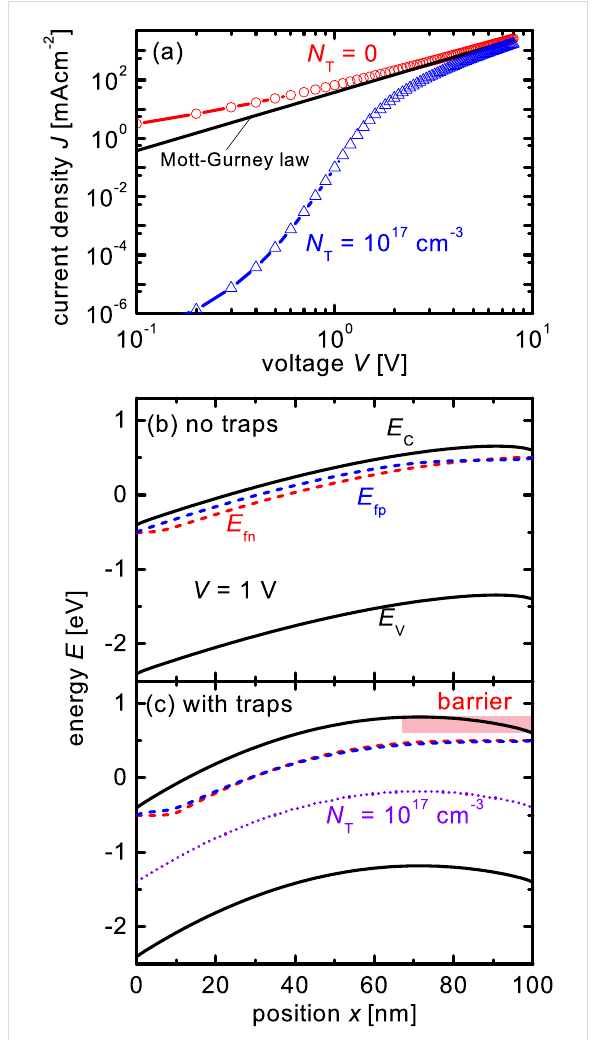
Figure 1: (a) Current–voltage curves of a device with and without charged acceptor-like defects with a total concentration N T = 10 17 cm − 3 and a Gaussian width of σ = 100 meV are compared to the Mott–Gurney law (Equation 1). Band diagram of the device (b) without charged defects and (c) with charged defects. The acceptor-like defects in (c) create a barrier (indicated with a light red background) due to their negative charge. The diffusion of electrons up the barrier causes the reduced current in